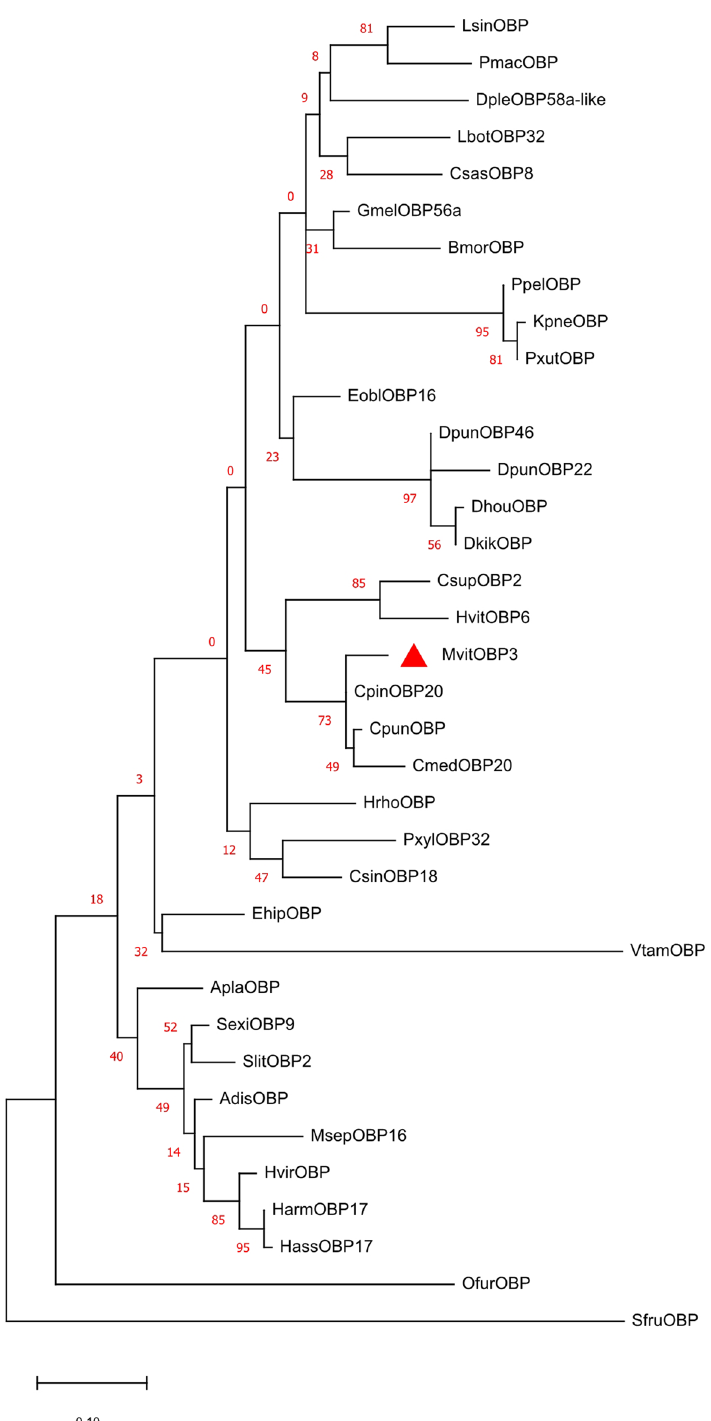
Figure 1. Evolutionary analysis of MvitOBP3 protein with other Lepidopteran insect OBPs. Genbank accession numbers: LsinOBP (VVC93553.1), PmacOBP (CAF4841106.1), BmorOBP